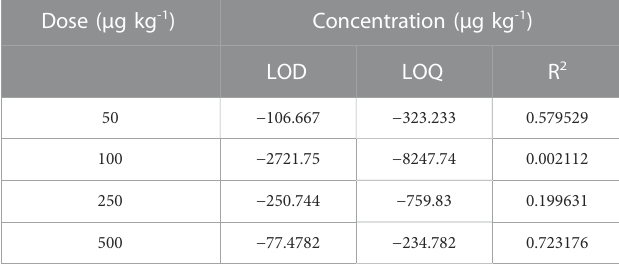
TABLE 7 Validation parameters of EB metabolite Emamectin B 1b . Dose (µg kg -1